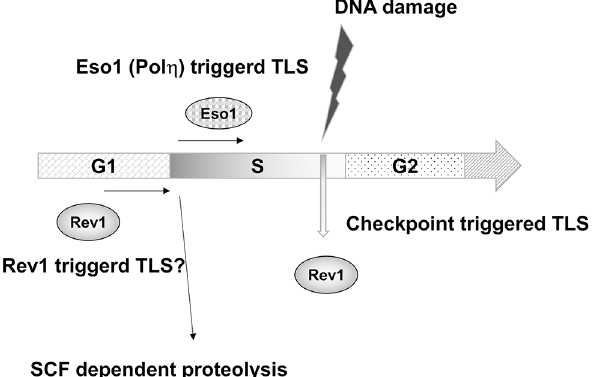
Fig 8. A model for the protein level regulation of Rev1 and TLS. In G1 phase, Rev1 is abundant and Rev1-dependent loading of TLS polymerase may occur. At the onset of S phase, Rev1 is destroyed in a SCF- dependent manner and chromatin-loaded Eso1/pol η serves as an initiator of TLS. When DNA is damaged, the DNA structure checkpoint increases the protein level of Rev1 and facilitates polymerase switching among TLS